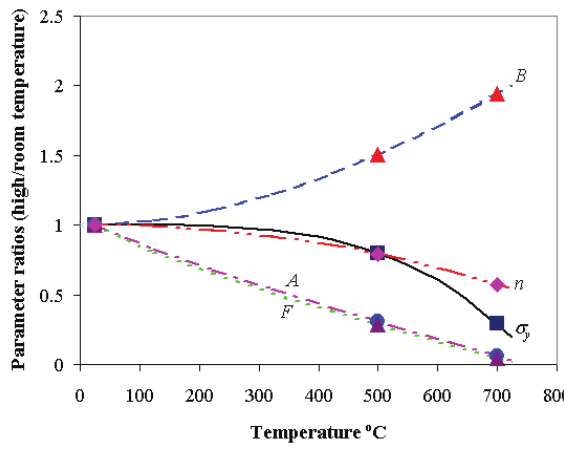
Figure 5. Fitting curves based on the relationship of mate- rial parameters and temperatures.